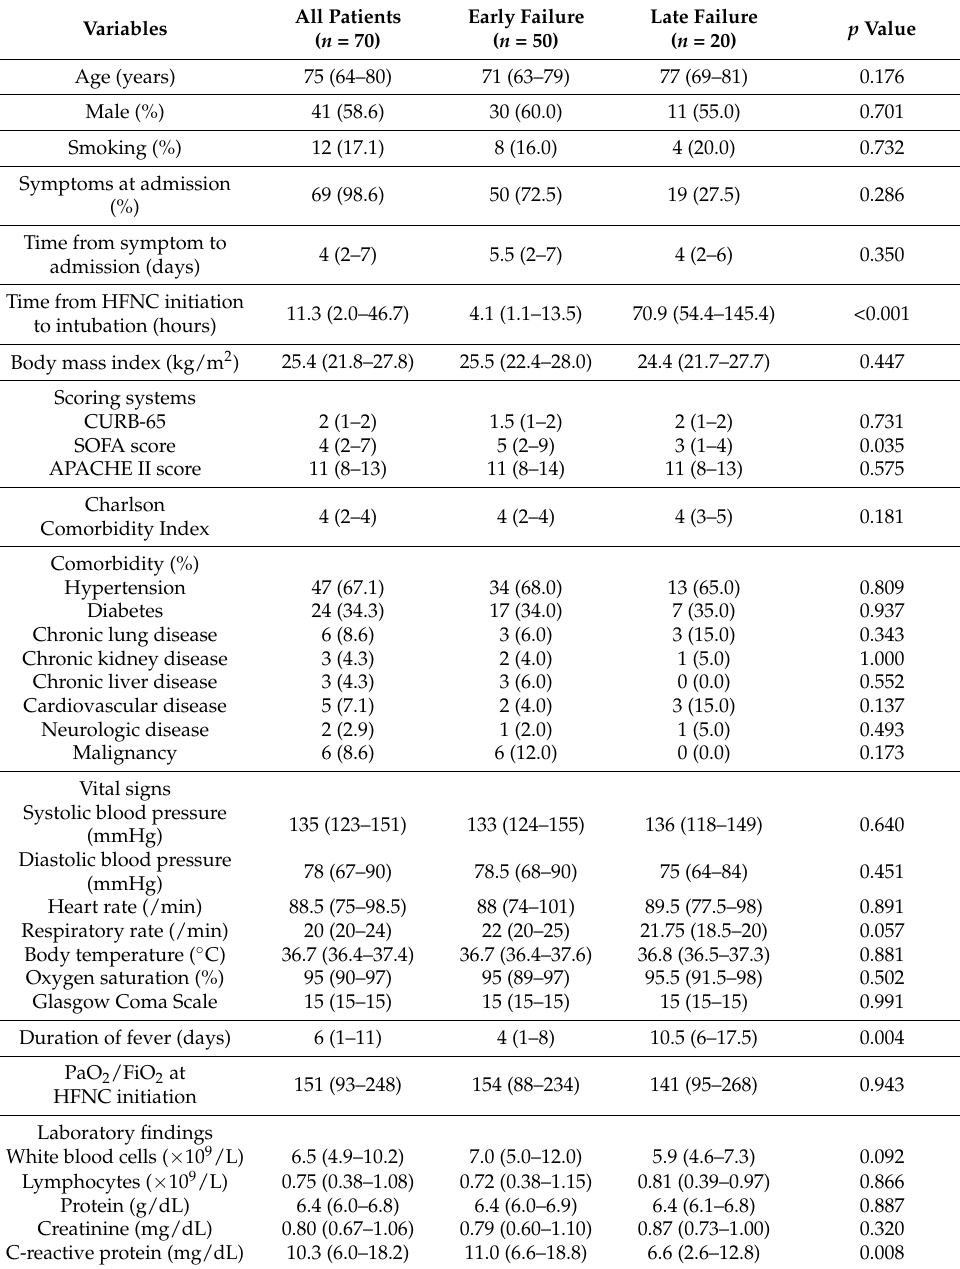
Table 1. Baseline characteristics of COVID-19 patients treated with mechanical